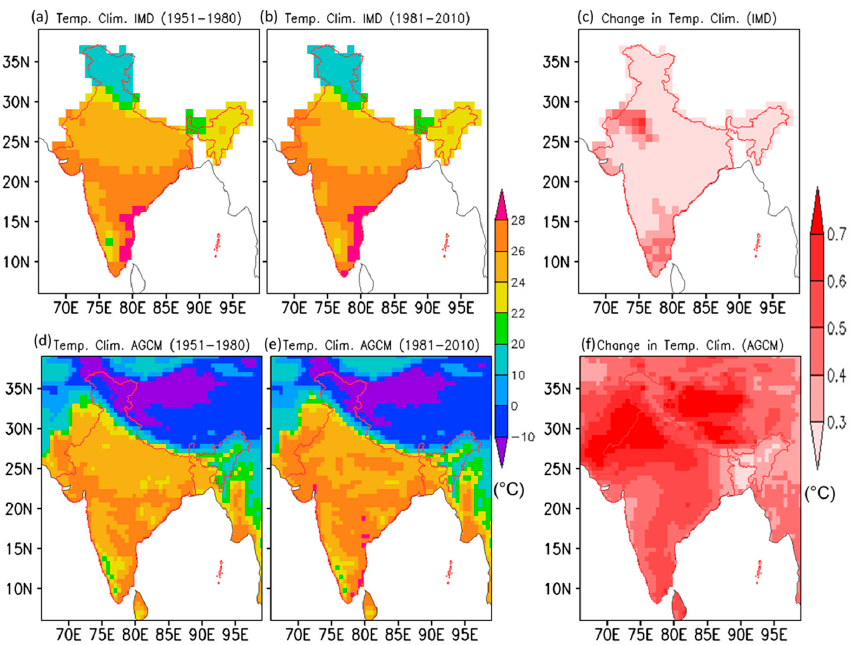
Figure 9. Temperature climatology in two climate periods from ( a , b ) AGCM ensemble and ( d , e ) IMD observation. Change in temperature climatology from ( c ) IMD and ( f ) AGCM. The model successfully represented variation of temperature pattern over Indian re- gion, but with slightly lower magnitudes compare to the observation, particularly few regions of north and south India, indicating a cold bias in the model for these regions. Overall, the model simulated mean surface temperature over most of Indian regions has a good agreement with the observation. The standard deviation of each individual ensem- ble climatology from their mean climatology is found in the range 0.5–0.15 °C (Figure 10). The comparison between the temperature climatologies during 1951–1980 and 1981–2010 indicates that the temperature is increased over entire region. Northwestern regions of India show maximum increase in temperature in recent climate period. Both model and observation show similar increased pattern of temperature (Figure 9c,f). The p-values from the Student’s t -test by assigning null hypothesis to no temperature change between the two periods at 95% significance level is found lower over most of the regions of India with exceptions over some regions of northern and southern India. So the temperature change over most of the Indian regions are significant although few regions show no tem- perature change. Overall, the increased temperature in the recent climate period is quali- tatively well represented in model simulations with higher values by about 0.2–0.3 °C.